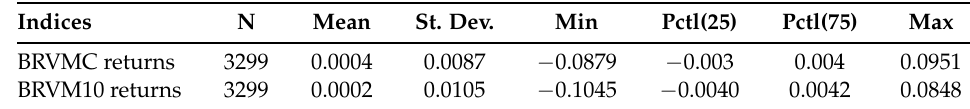
Table 1. Summary statistics on the BRVMC and BRVM10 returns. Indices N Mean St.